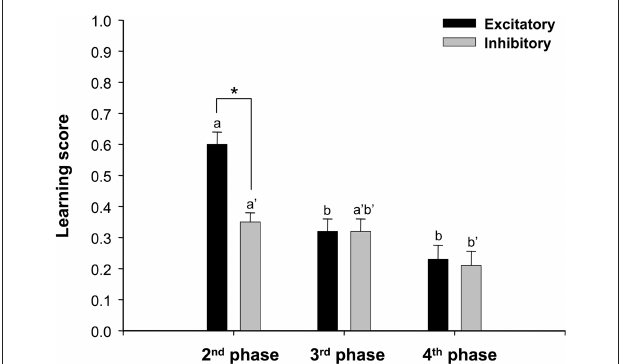
Figure 2 | Average excitatory ( ∆ ) and inhibitory ( ∆ ) reversal learning e i scores ( + S.e.) computed for three consecutive reversal phases (2nd, 3rd, and 4th conditioning phases) . ∆ was calculated as the difference in e responses to the CS + between the fifth and the first trial of a reversal phase ( ∆ = CS + – CS + ); ∆ was the difference in responses to the CS − between Figure 3 | Average differentiation index (Di) obtained in the four e trial5 trial1 i the first and the fifth trial of a reversal phase ( ∆ = CS − – CS − ). Statistical consecutive differential conditioning phases ( + S.e.). Di was calculated as i trial1 trial5 comparisons of excitatory scores between phases are indicated by letters (e.g. the difference between the responses to the CS + minus the responses to the a, b). Comparisons of inhibitory scores between phases are indicated by CS − in the last conditioning trial of each phase (Di = CS + difference between the Dis of the 3rd and 4th phase was marginally non-significant ( P = 0.055). n = 111 bees.